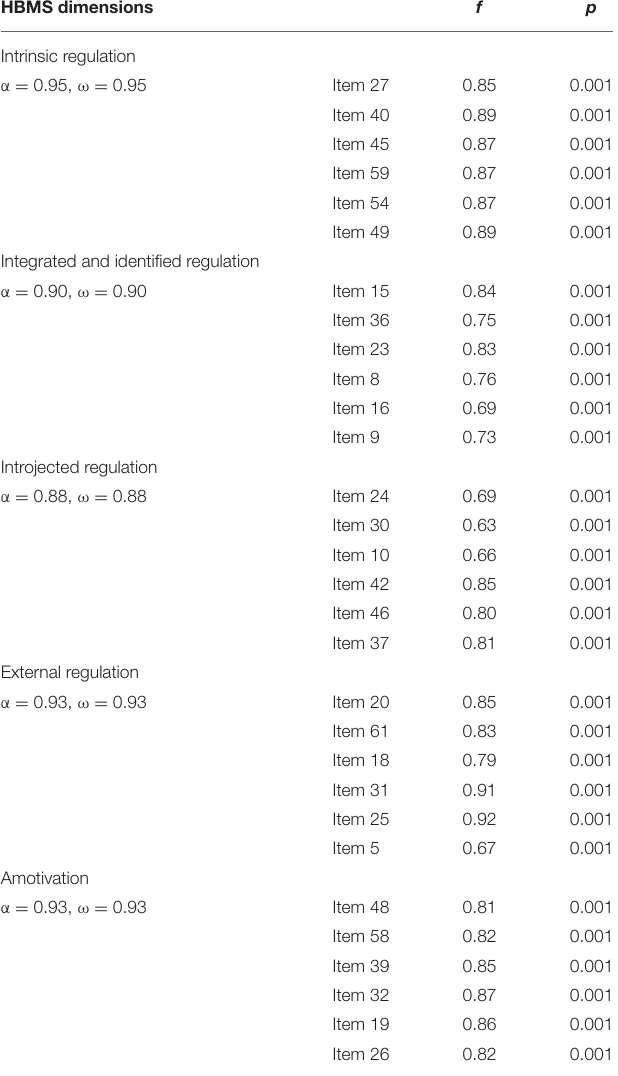
TABLE 4 | Factor loadings in CFA for 30-item health behavior motivation scale (HBMS), Study